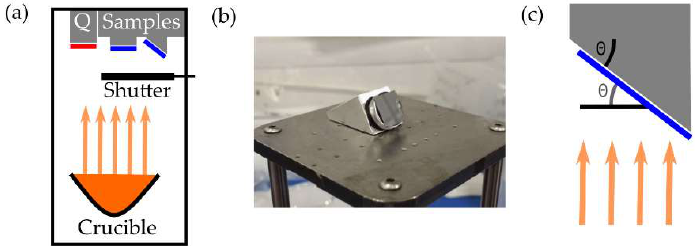
Figure 5. Thermal evaporation of a magnetic material. ( a ) Schematic of thermal evaporator components. A crucible containing Permalloy is heated to deposit a thin film onto the samples and a Quartz crystal microbalance (Q); ( b ) Angled holder used to perform thermal evaporation perpendicular to the nanostructures; ( c ) Schematic of a thermal evaporation process perpendicular to a nanostructure (black), and therefore at an angle θ to the substrate (blue).